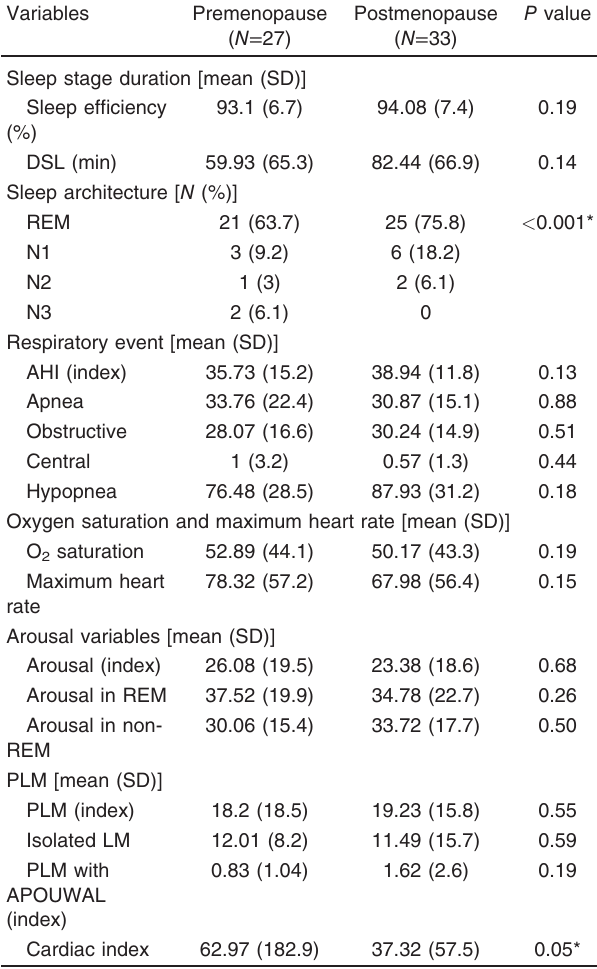
Table 5 Findings of polysomnography of the study groups Variables Premenopause Postmenopause ( N = 27) ( N =